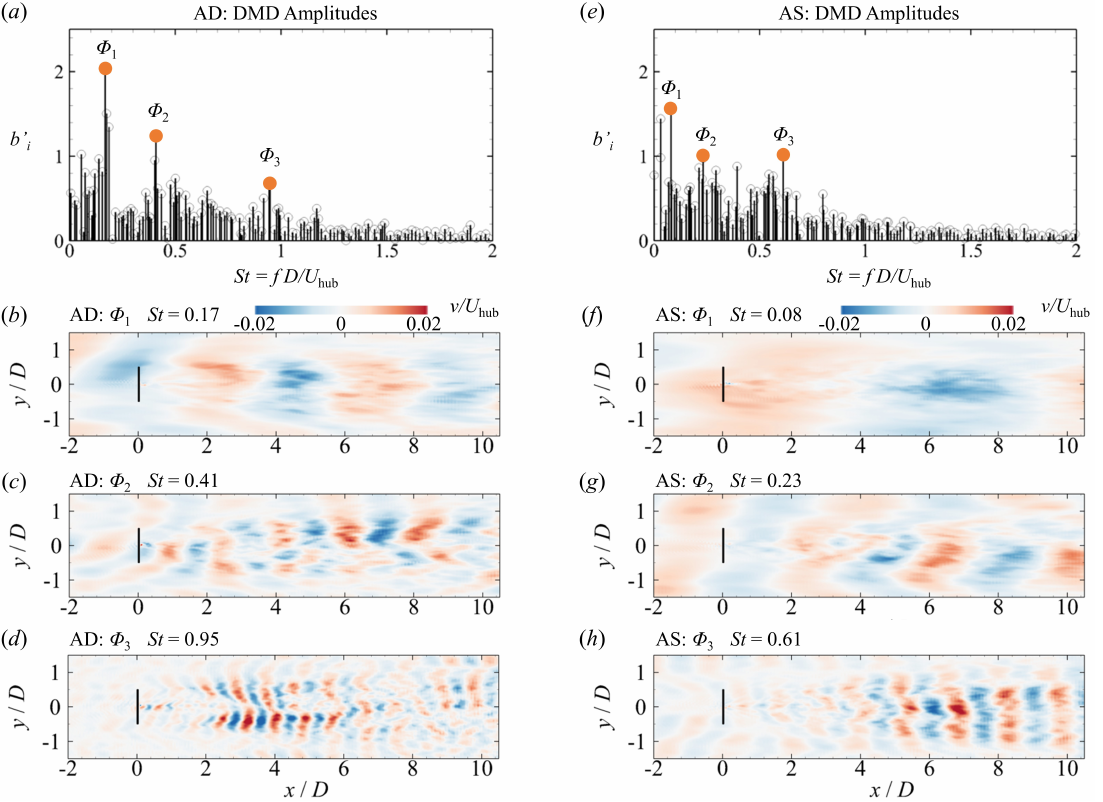
Figure 7. Turbulent inflow: Dynamic mode decomposition (DMD) analysis of the velocity field on the horizontal plane at the hub height ( z = z hub ). ( a , e ) the eigenvalue-weighted amplitudes of the DMD modes for the AD and the AS models; ( b – d ) the largest three DMD modes ordered by Strouhal number of AD; ( f – h ) the largest three DMD modes ordered by Strouhal number of AS. DMD modes are shown with the spanwise velocity